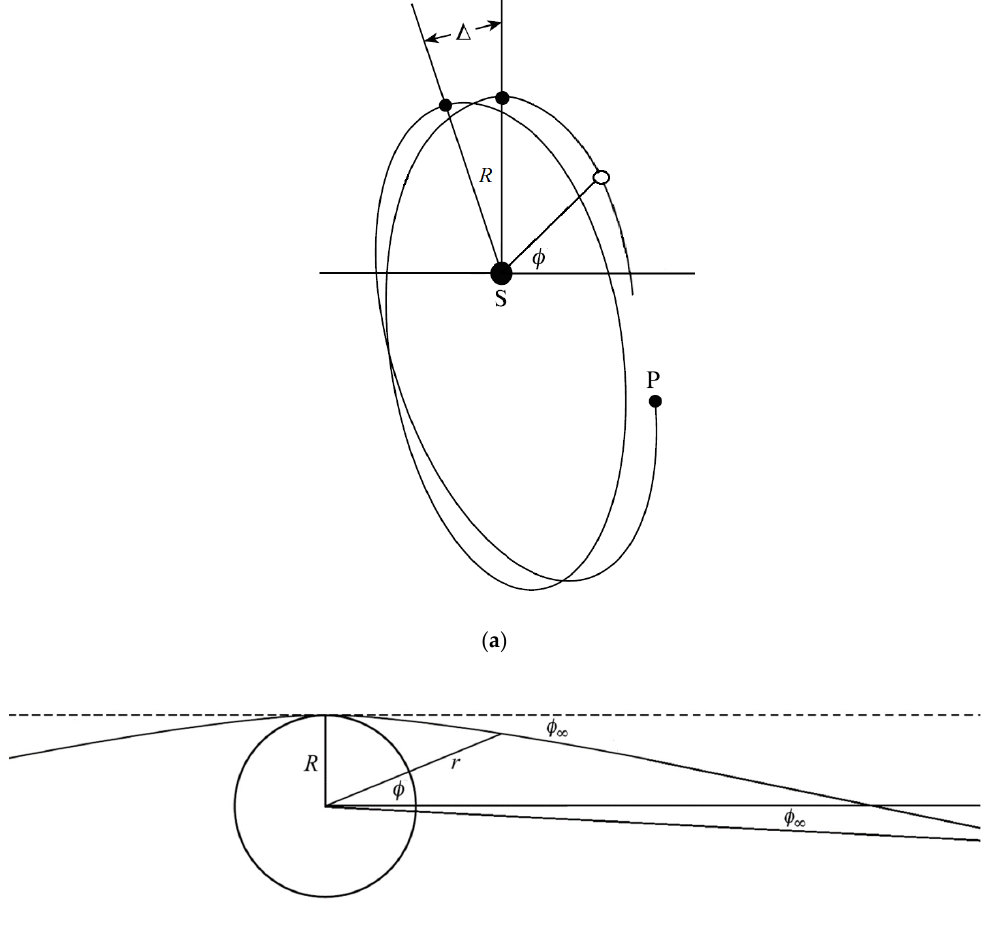
Figure 1. ( a ) Precession of the pericenter (perihelion) of a particle/planet due to a spherical mass (the Sun). ( b ) Gravitational deflection of a ray due to a spherical mass (the Sun). R is the (minimum) distance of the pericenter (perihelion) from the center of gravity, Δ is the angle that the perihelion precesses per revolution, and ϕ ∞ is the half gravitational deflection of a ray. The Newtonian scalar gravitational potential